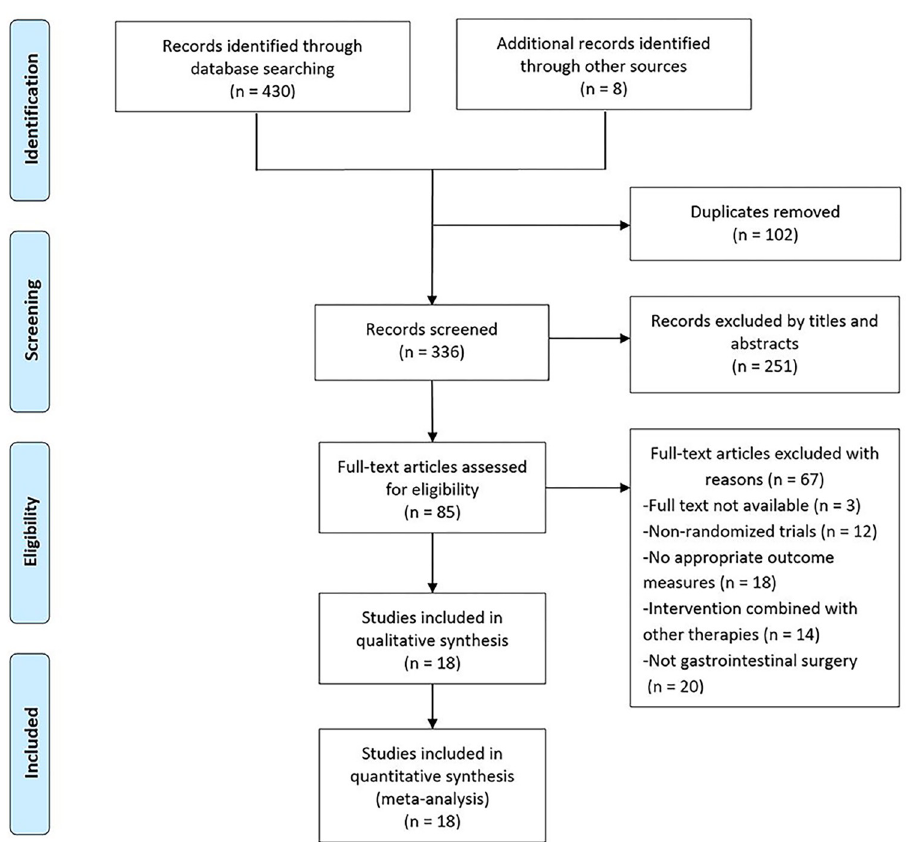
Fig 1. The flow diagram of study